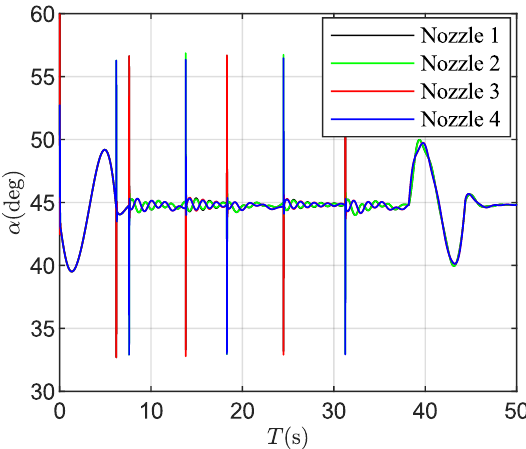
Figure 13. Changes in the nozzle angles in the